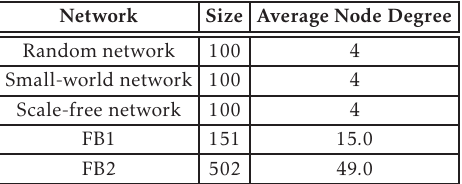
dynamic plot consists of 7 curves corresponding to 7 attributes, Attr #1, Attr #2, ..., Attr #7, which are numbered according to their importance (weight),